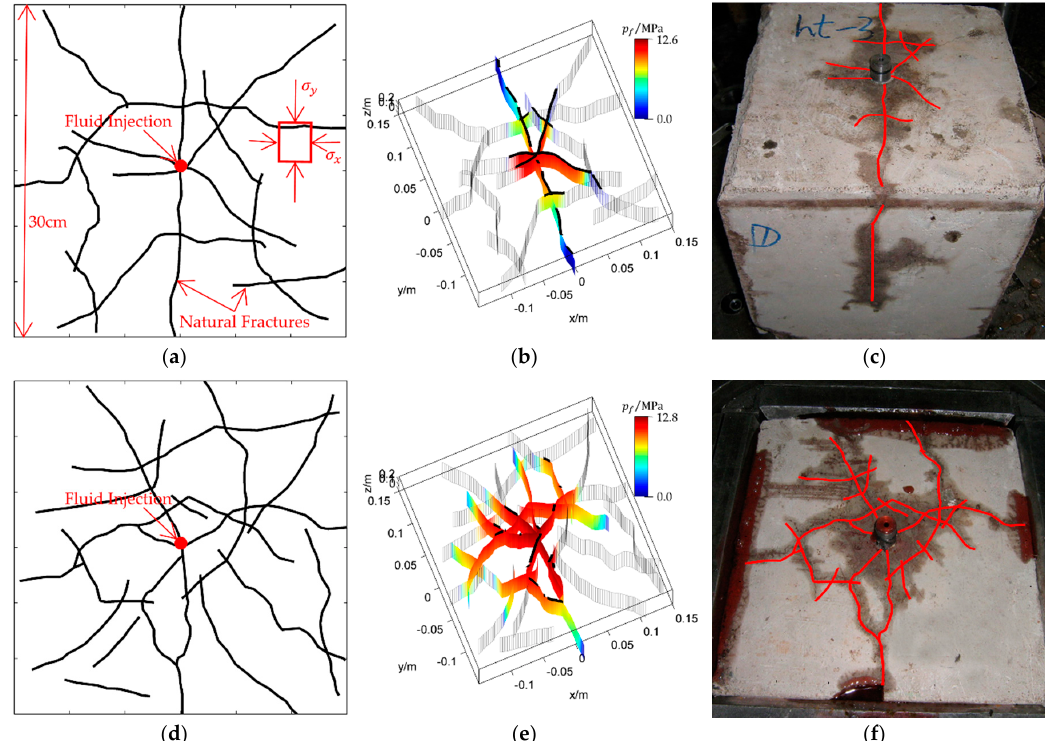
Figure 1. Pre-existing fractures on the surface of a block after heat and cooling treatments from Zhou et al. [16].